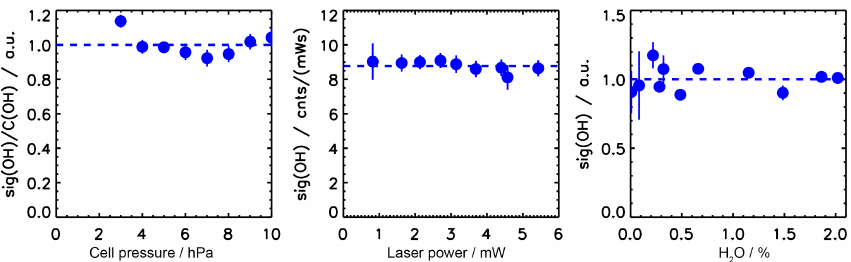
Figure 10. OH signals when air containing NO 3 produced from thermal decomposition of frozen N 2 O 5 is sampled depending on the cell pressure, laser power, and water vapour content of the air. No significant change of the signal is observed for either of the parameters. Tests were done with the instrument with the short inlet.